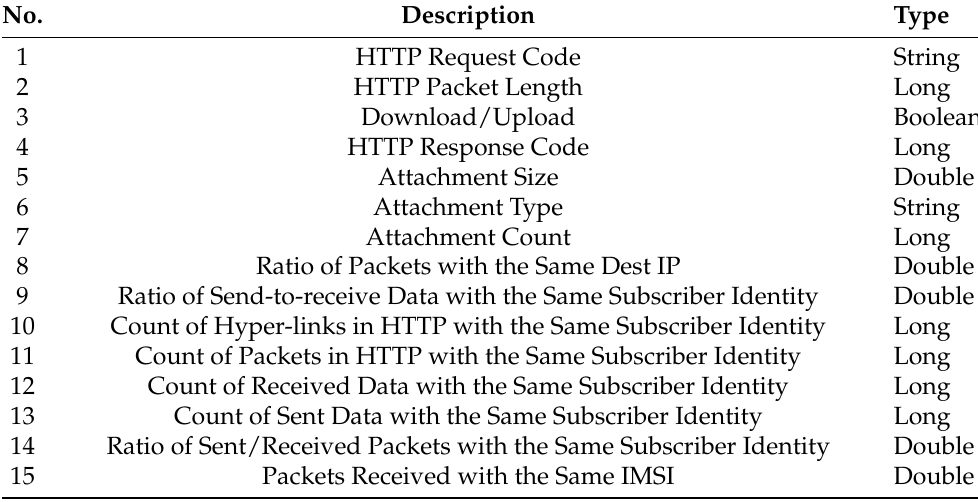
Table 2. Evaluated features.